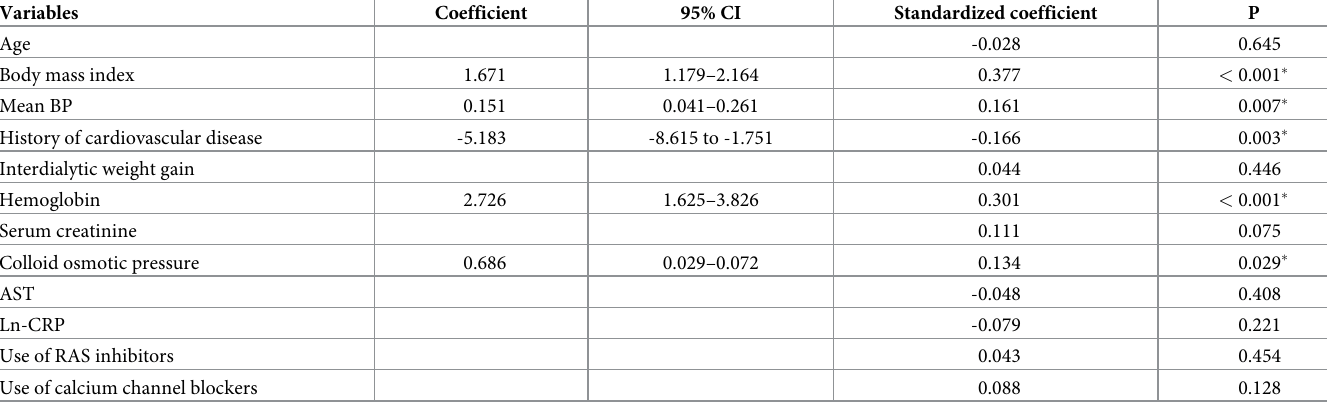
Table 3. Multivariable linear regression analysis in Model 2 using colloid osmotic pressure: Factors independently associated with hepatic rSO 2 in patients undergo- ing